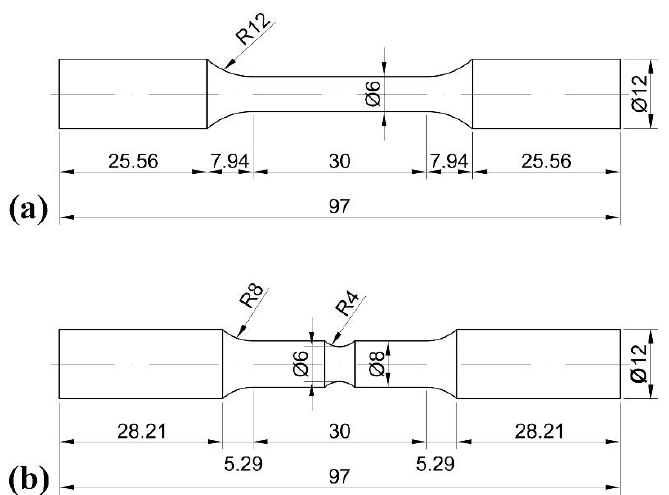
Figure 4. Shapes and dimensions of specimens under dwell fatigue and conventional fatigue tests (in mm). ( a ) Smooth specimen; ( b ) specimen with a circumferential notch.